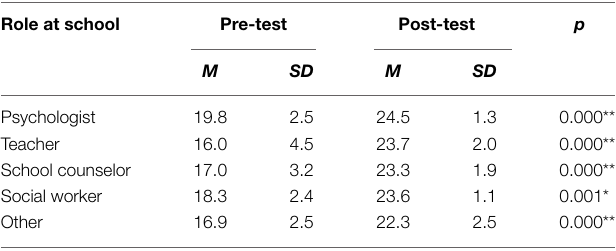
TABLE 6 | Pre- and post-test total score of the Knowledge Questionnaire of Adolescent Depression for School Staff by participant role at school . Role at school Pre-test Post-test